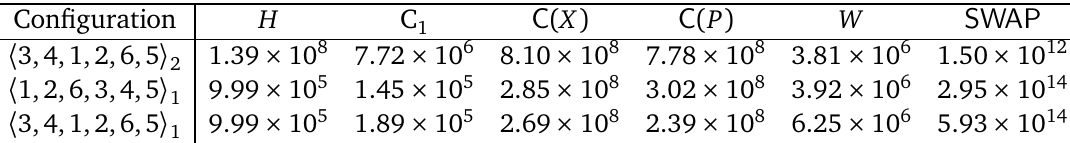
and 2 when using forced- , 〈 3,4,1,2,6,5 〉 1 1